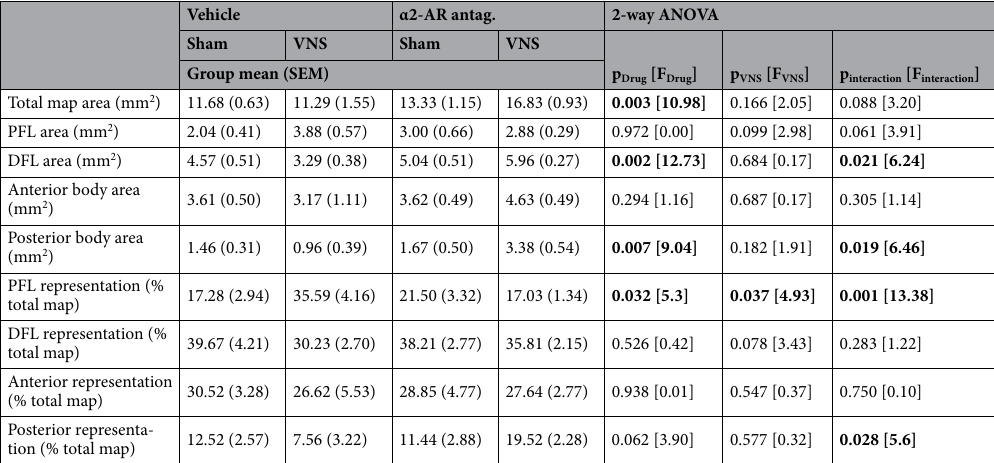
Table 1. Comparison of motor map areas across treatment groups. Within 24 h of the last training-paired treatment session, cortical motor maps were obtained using ICMS. ICMS-evoked movements at threshold amplitudes were classified as proximal forelimb (PFL), distal forelimb (DFL), anterior body (vibrissa, jaw, or neck), or posterior body (trunk, hindlimb, or tail) movements. VNS treatment resulted in an expansion of the task-relevant proximal forelimb representation, which was blocked by M1 infusion of α2-AR antagonists. Bold denotes statistical significance (p < 0.05).